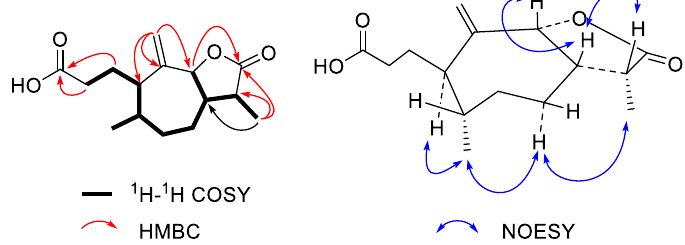
Figure 5. Key 1 H- 1 H COSY, HMBC, and NOESY correlations of 4 . Known compounds were identified by comparison with the experimental and re- ported spectroscopic data as follows: (-)-compressanolide ( 5 ) [17], magnograndiolide ( 6 ) [18], 1 β ,7 β ,9 β ,10 β ,13 α H-guaia-4(5)-en-12,6 β -olide-9- O - β - D -glucoside ( 7 ) [19],